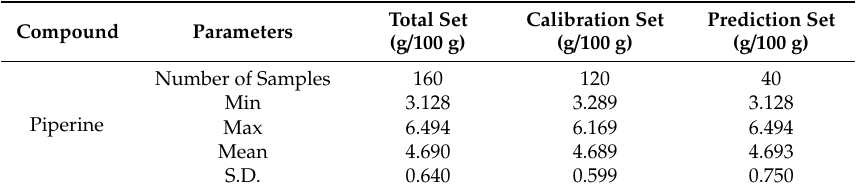
Table 1. Statistics for piperine in ground black pepper for the calibration and prediction set of the reference method.